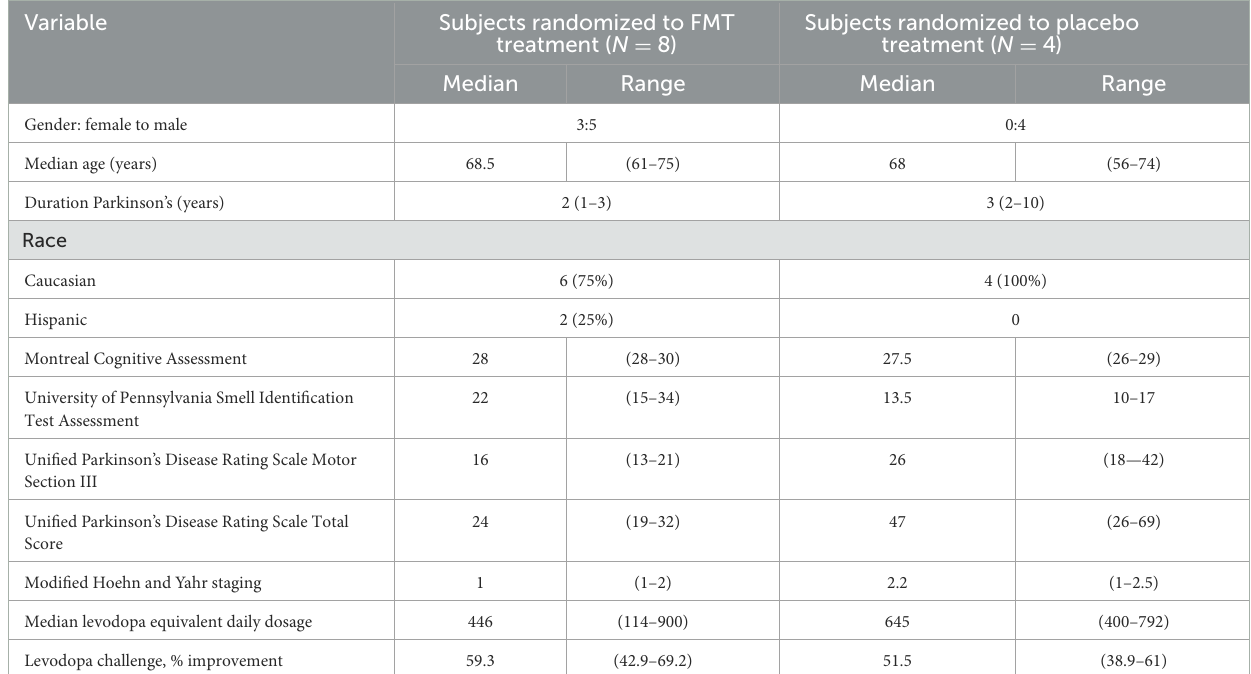
TABLE 1 Demographics and baseline values for examinations, questionnaires, and clinical findings of the two study population. Variable Subjects randomized to FMT treatment ( N =